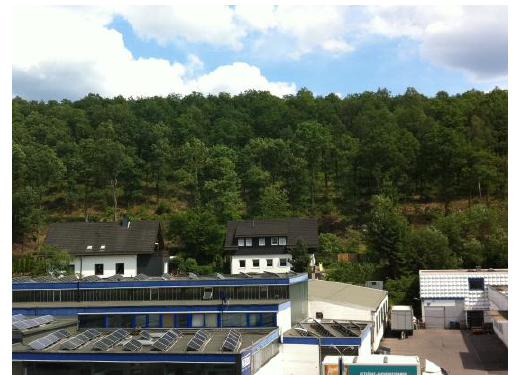
Figure 11. Shadow area in the